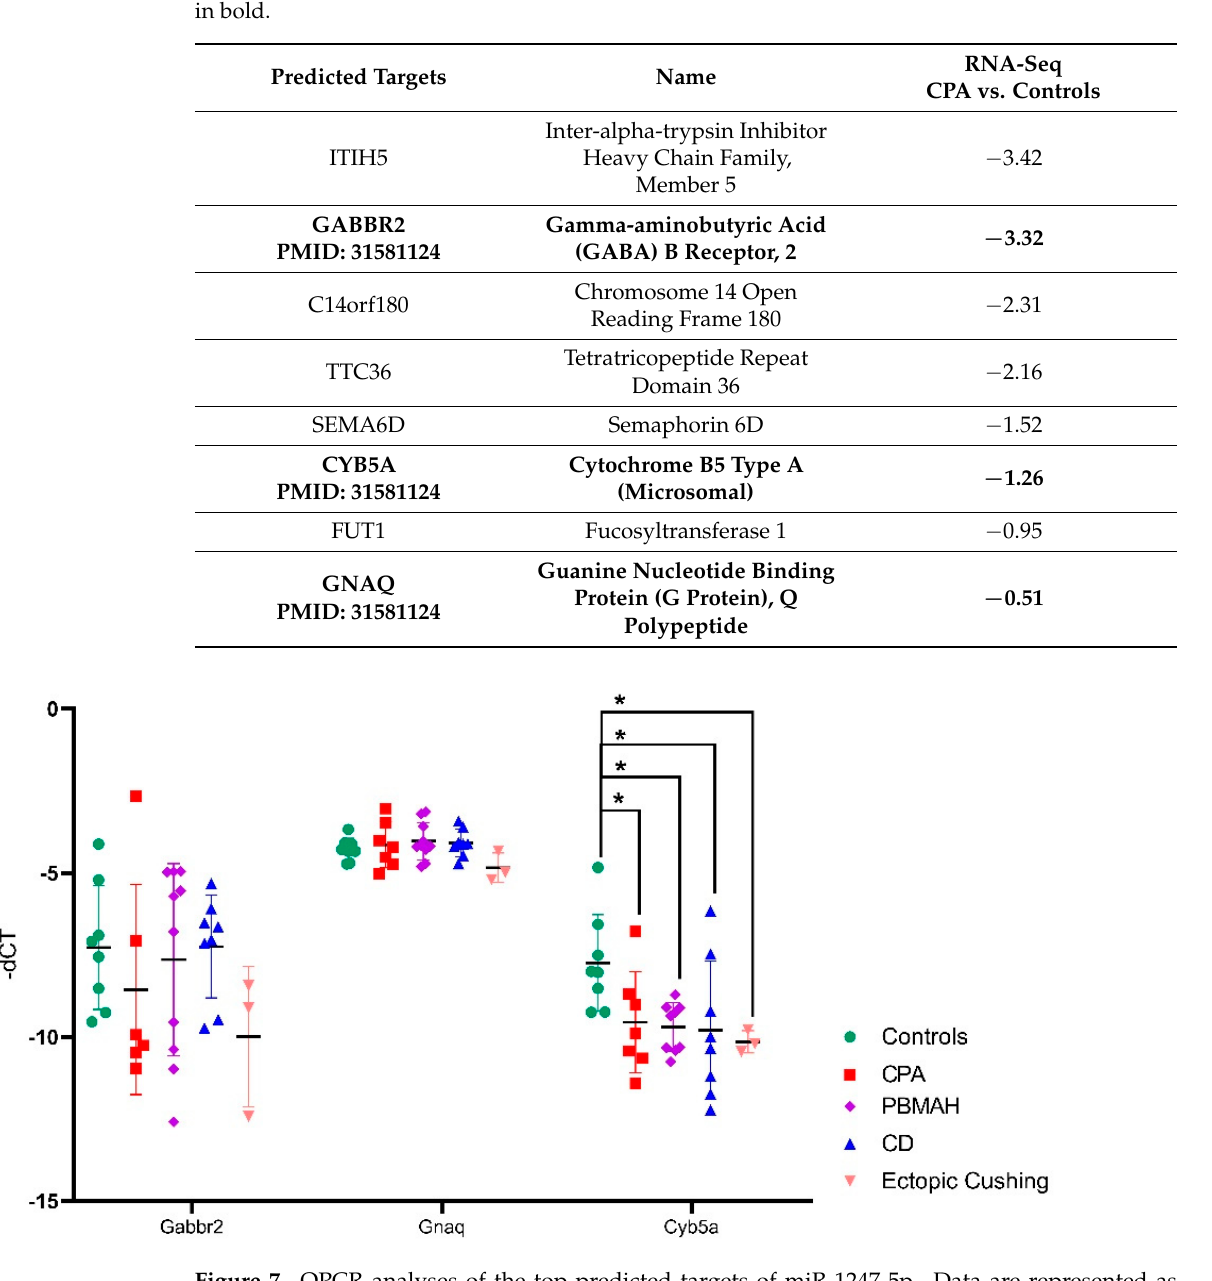
Figure 7. QPCR analyses of the top predicted targets of miR-1247-5p. Data are represented as mean ± standard deviation (SD) of − dCT values. Housekeeping gene: PPIA. Statistics: ANOVA test with Bonferroni correction to detect significant differences between patient groups with at least a significance of p -value < 0.05 (*).